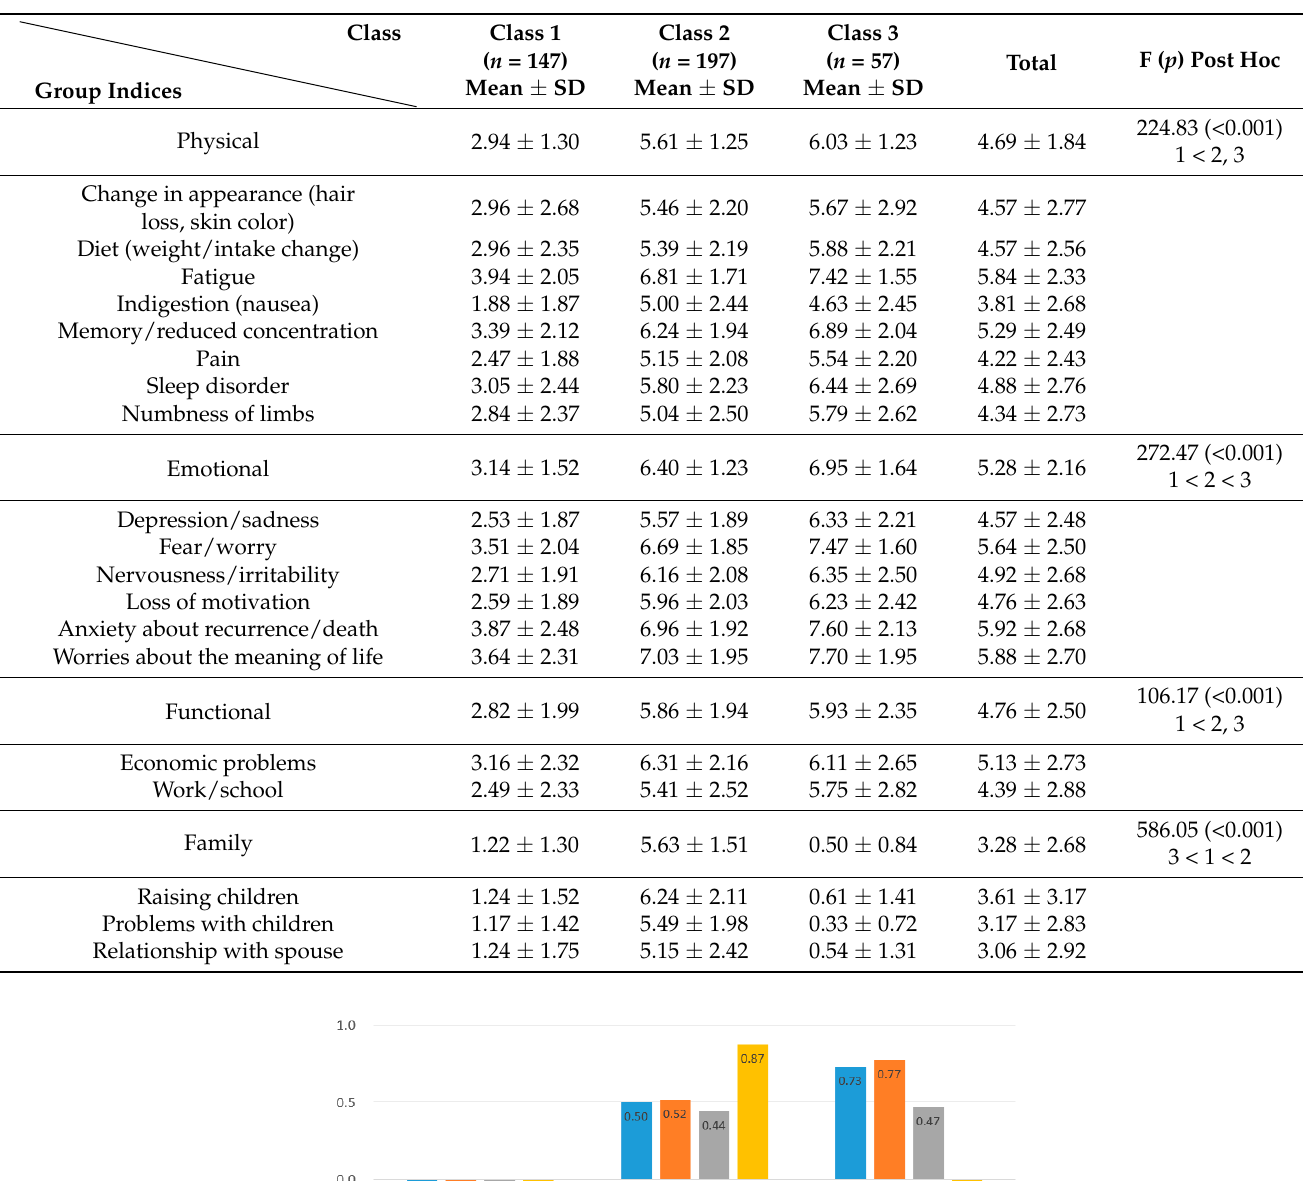
Table 3. Differences of Indices of Problem List Among Latent Classes ( N = 401).